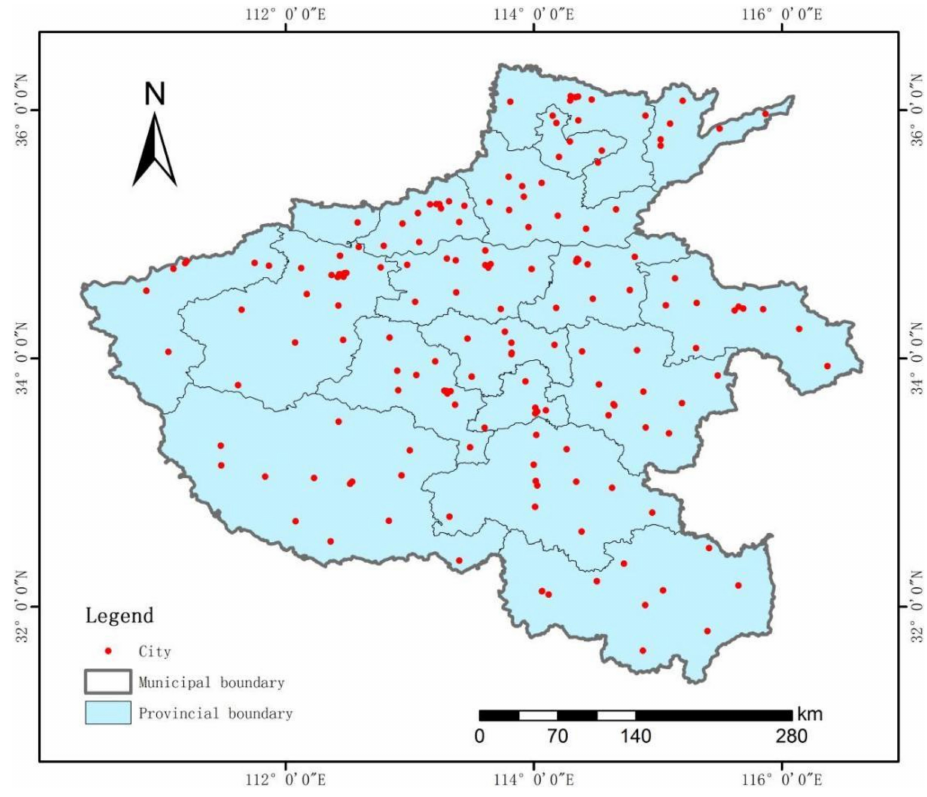
Figure 3. Distribution of target cities in Henan